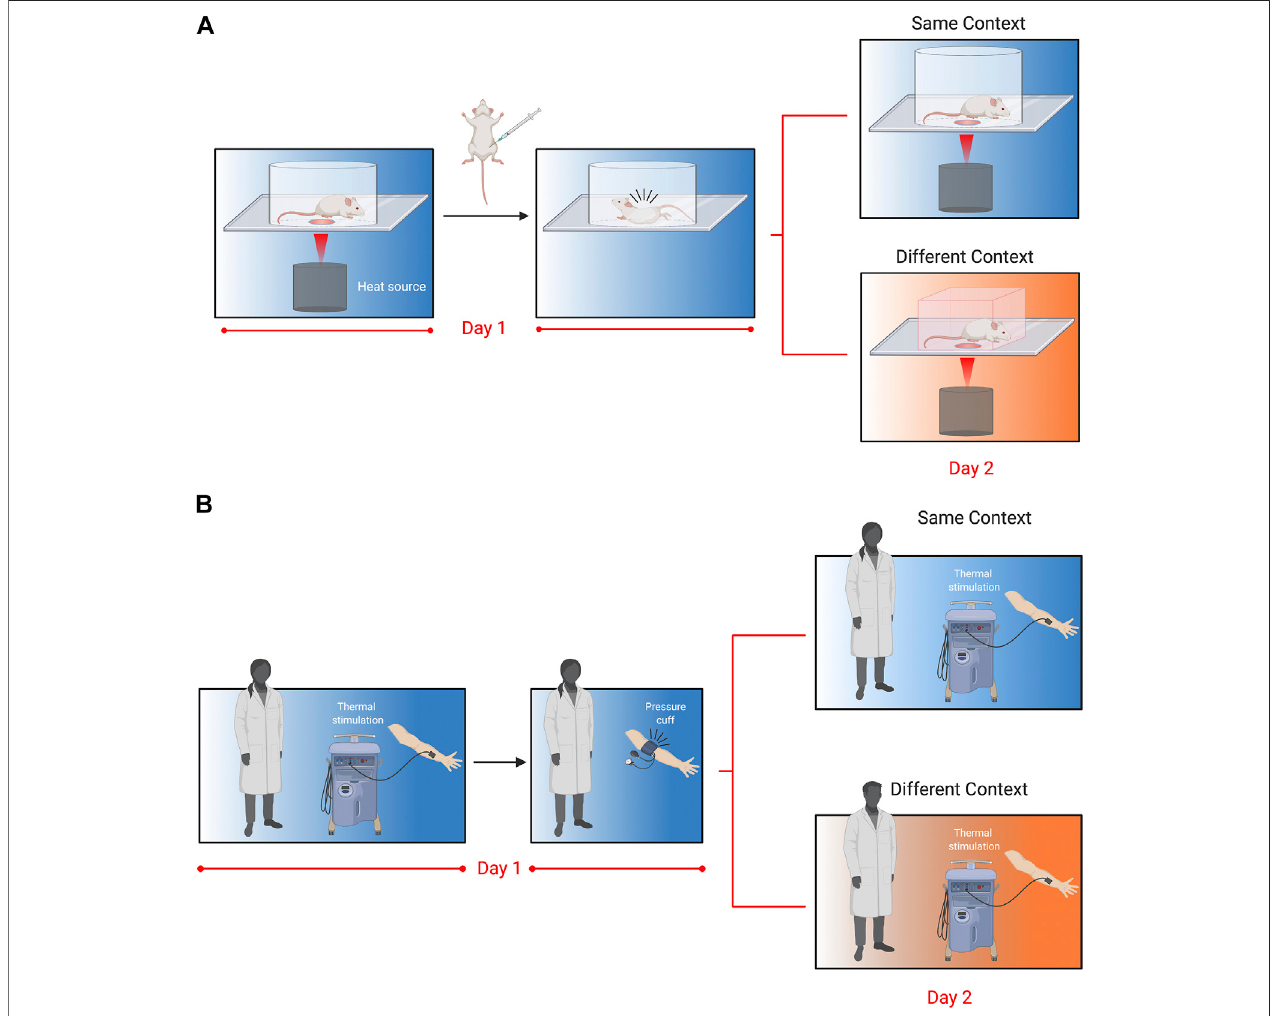
FIGURE 1 | Translational behavioral models to test pain memory in mice and humans as originally reported in Martin et al., 2019. (A) . Mice are placed in Plexiglas cylindersandpawwithdrawalthresholdsevokedbythermalstimuliaremeasuredevery5 minfor30 min.Followingbaselinemeasurements,miceareinjectedwithacetic acid (i.p.,; 0.9%), which causes abdominal cramps and nociceptivewrithing behaviorthatlasts forapproximately 30 min. Twenty-fourhours later,mice areplaced either back in the same cylinder in the same room, or in a novel cubicle in a different room, and again tested for thermal withdrawal latencies. Nociceptive sensitivity was increased in mice returned to the same context 24 h following acetic acid injection, but this was only observed in male mice. Follow-up experiments revealed that enhancednociceptive sensitivity inmales wasdependent ontestosterone, thestressresponseandatypicalPKCs. (B) .Inthehumanmodel, participants weretested for their thermal sensitivity to a heat probe placed on the volar aspect of the forearm. Volunteers were then subjected to a submaximal effort ischemic tourniquet test for 20 min.Twenty-fourhourslater,participantsweretestedforthermalsensitivityinthesameroombythesameexperimenter,oradifferentroom(inadifferentbuilding)and a different experimenter. Participants returned to the same room rated the thermal pain as higher, but this was only observed in men and associated with their pre-test stress response.